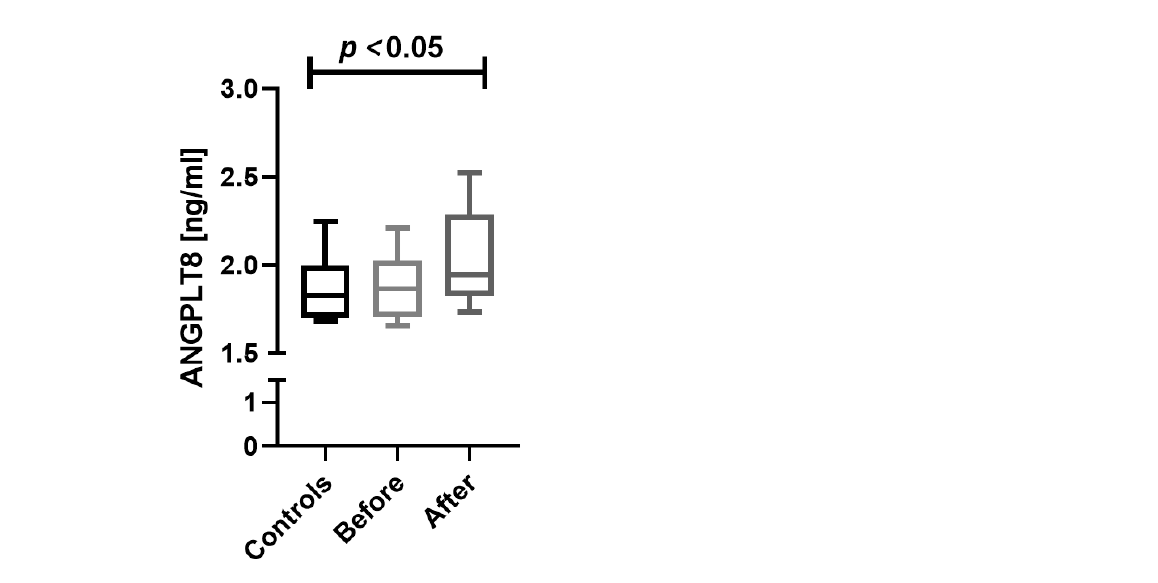
Figure 1. Serum ANGPTL8 concentration in controls and patients with psoriasis—before and after administered treatment. Table 2. The presence of correlations between ANGPTL8 serum concentrations and studied parame- ters before and after treatment in psoriatic